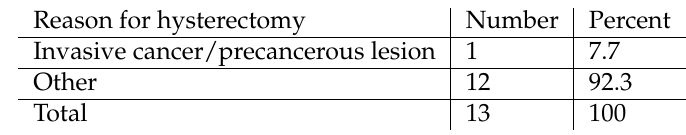
Table 4. Reason for hysterectomy in those who had a history of hysterectomy and were undergoing Pap smear